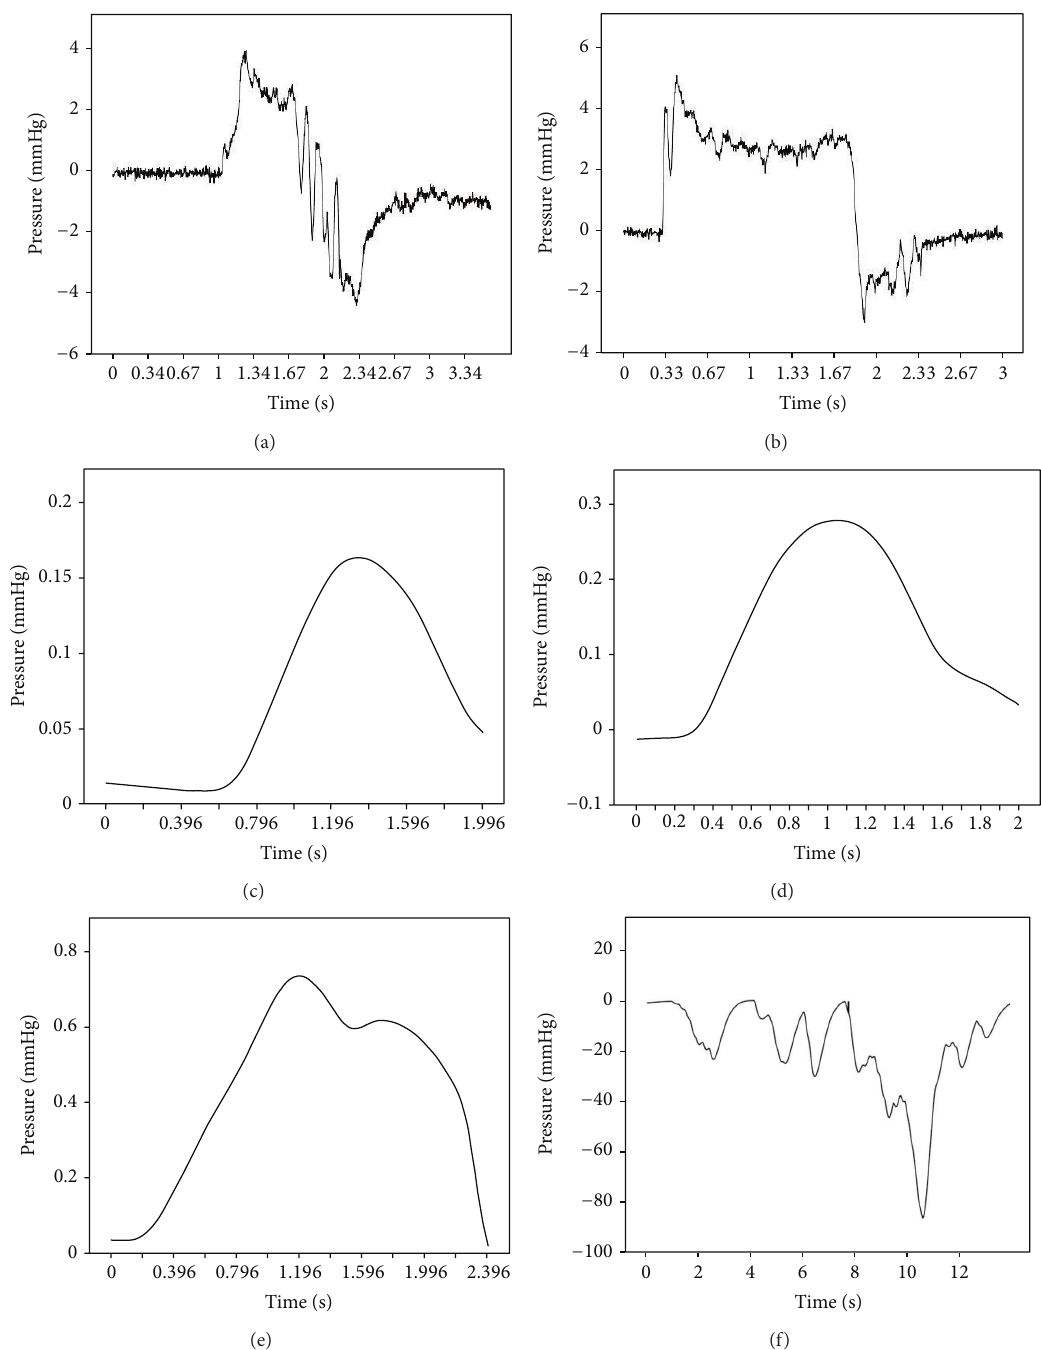
Figure 3: (a) Biphasic pressure change related to opening of the round window membrane with a needle. (b) Biphasic pressure change related to opening of the round window membrane with a cannula. (c) Unidirectional pressure change through opening of the round window membrane with a diode laser (4W). (d) Unidirectional pressure change through opening of the round window membrane with a diode laser (6W). (e) Unidirectional pressure change through opening of the round window membrane with a diode laser (10W). (f) Unidirectional pressure change through opening of the round window membrane with a CO 2 laser